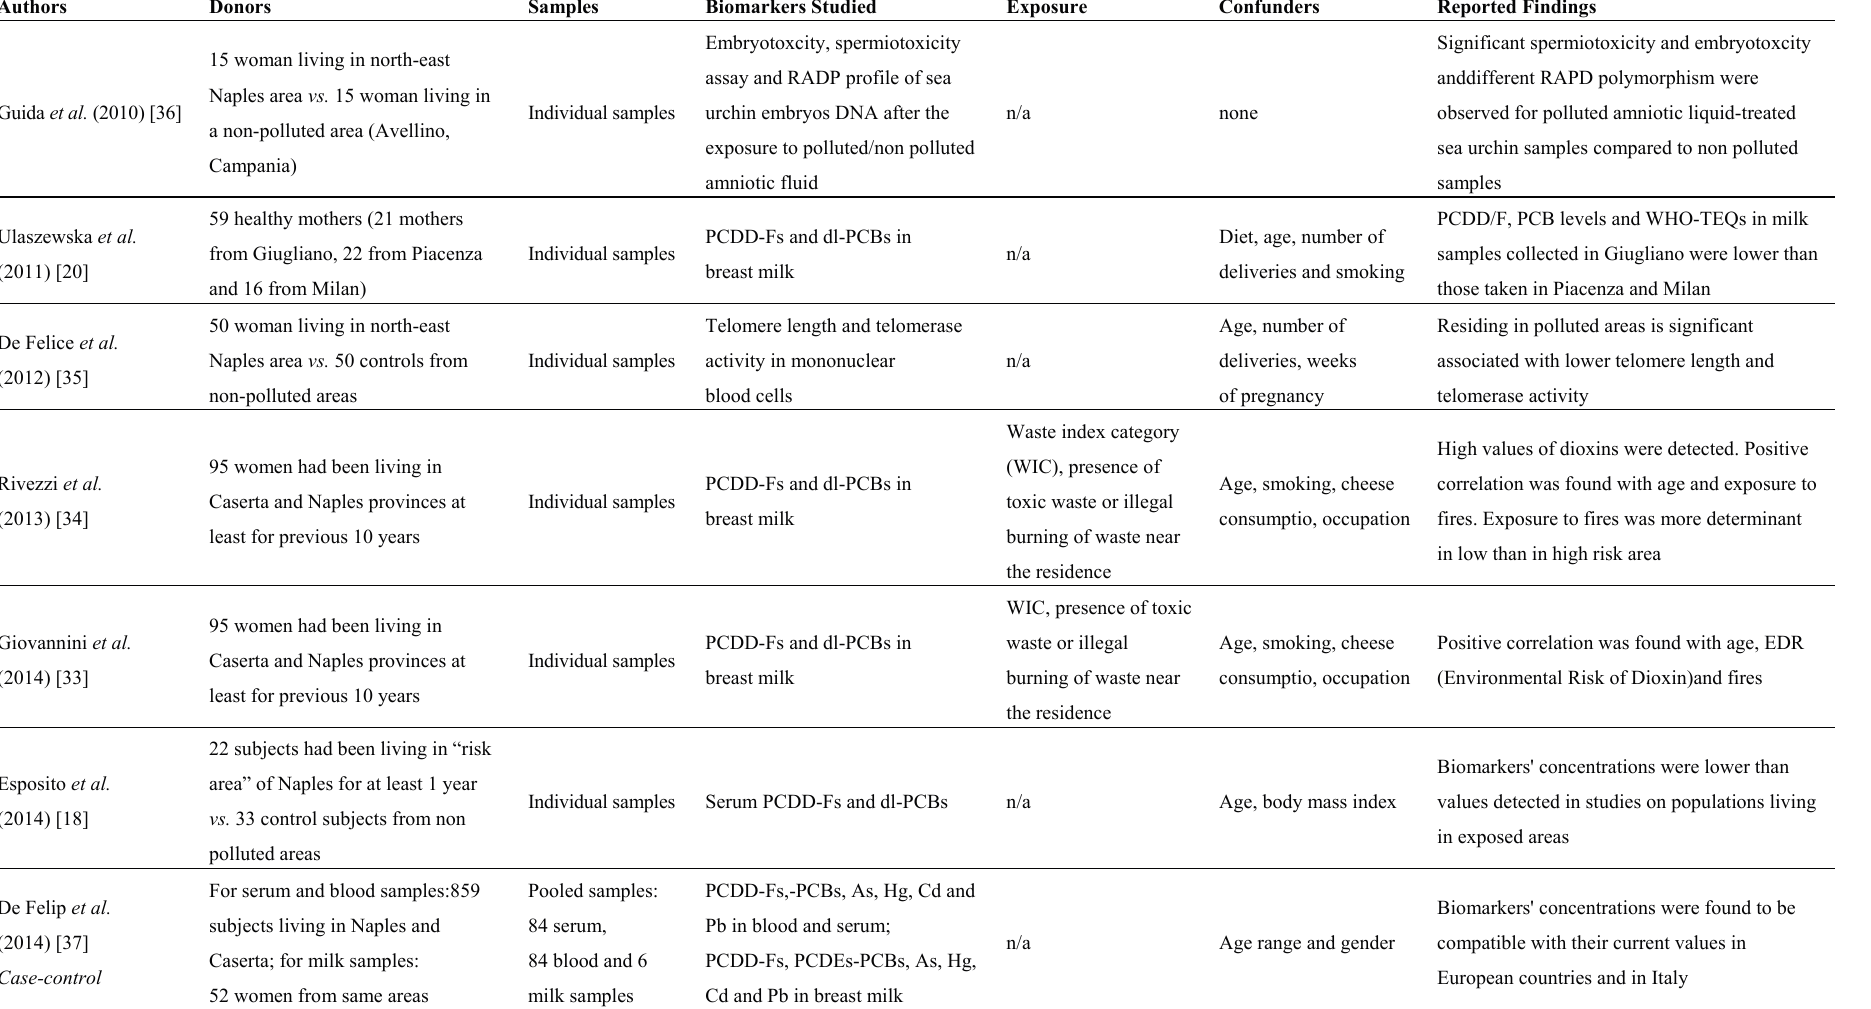
Table 2. Summary table of studies on human